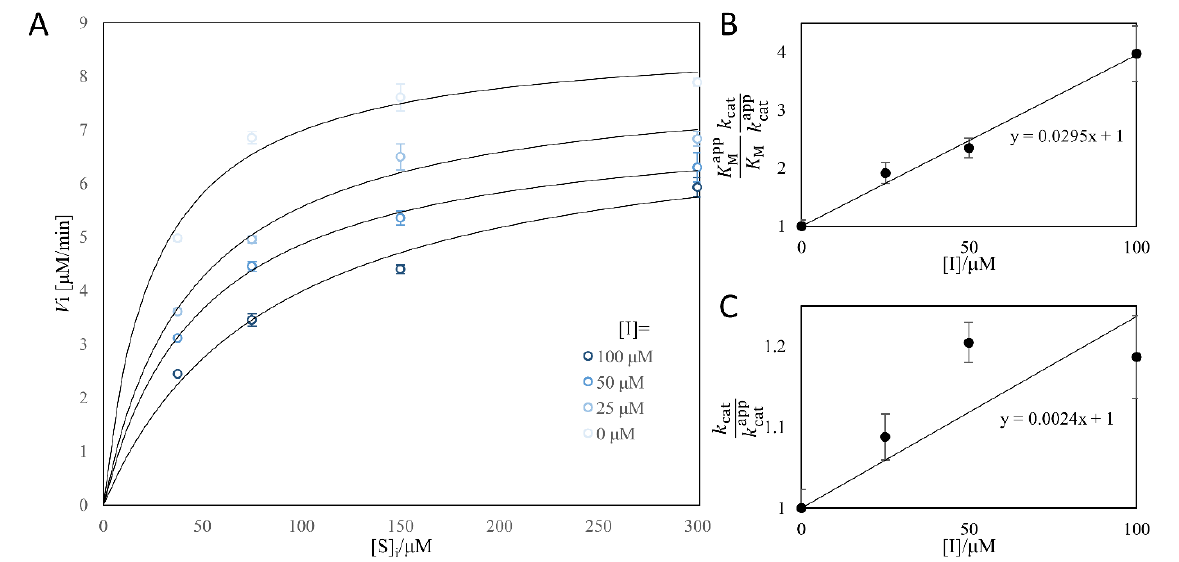
Figure 9. Mixed inhibition of Bm Ty by quercetin. Initial rates of Bm Ty were decreased when quercetin concentration was increased in the range of 0~100 μ M quercetin and 37.5~300 μ M L-tyrosine ( A ). Regression of two parameters derived two inversed inhibition constants, K I1 = 33.9 μ M and K I2 = 417 μ M, which means that quercetin is a highly competitive mixed inhibitor ( B , C ). Data were shown as averages and standard errors from triplicated samples.